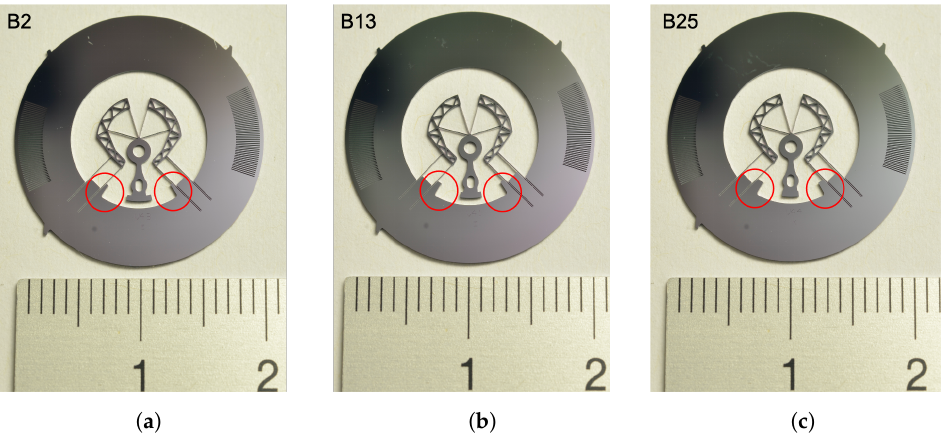
Figure 6. Silicon co-RCC prototypes with different values of imbalance caused by the mass variation in the symmetrical silicon outgrowths (circled on the figure): ( a ) prototype B2 with B = 1.83 nNm, ( b ) prototype B13 with B = 12.6 nNm, ( c ) prototype B25 with B = 24.7